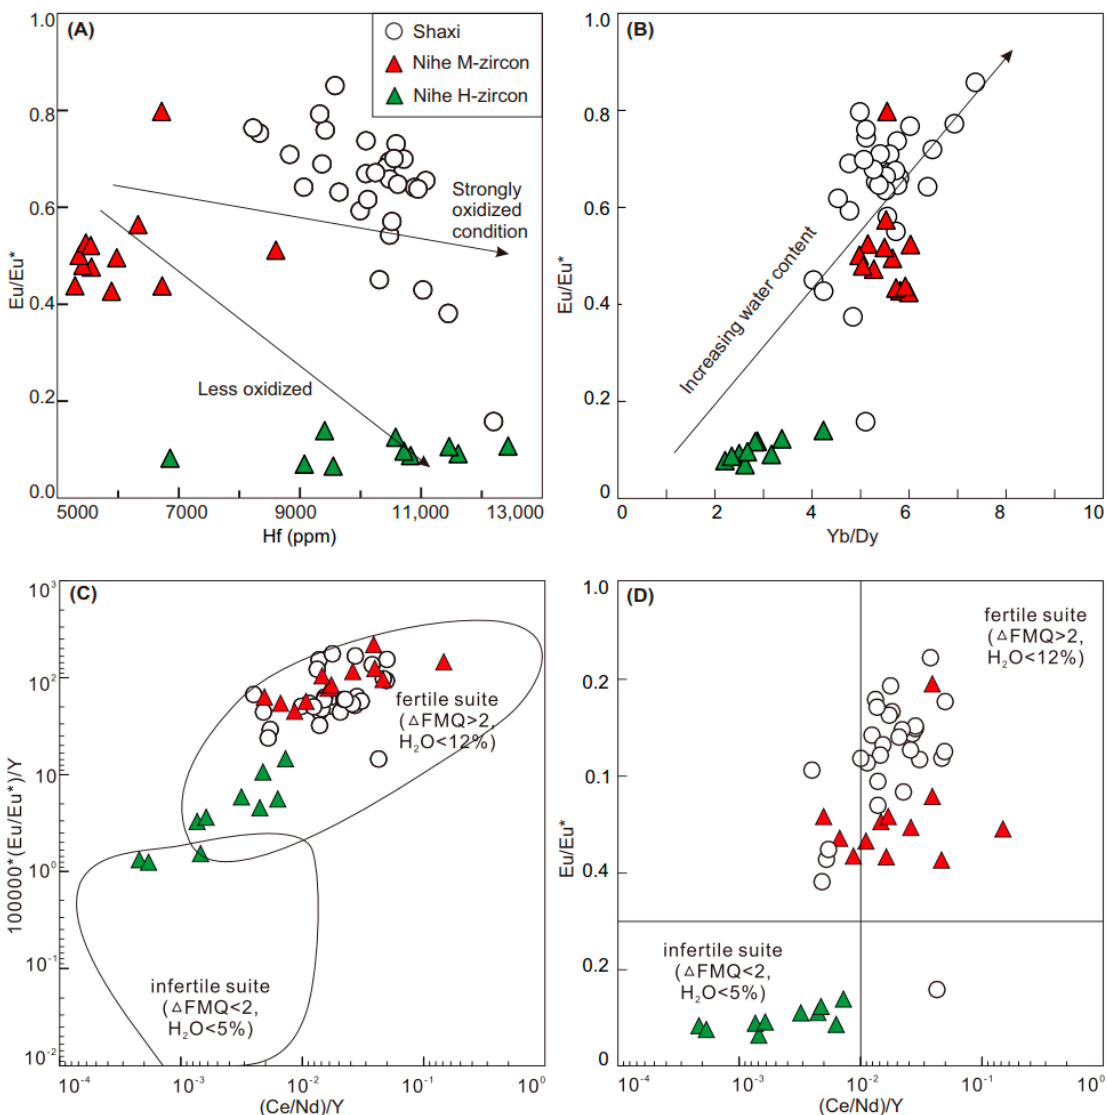
Figure 10. Diagram of zircon trace elements on Hf vs. Eu/Eu* [71] ( A ) and Yb/Dy vs. Eu/Eu* [24] ( B ). Diagram of zircon Eu/Eu* vs. (Ce/Nd)/Y ( C ) and 10,000 × (Eu/Eu*)/Y vs. (Ce/Nd)/Y ( D ). The zircon